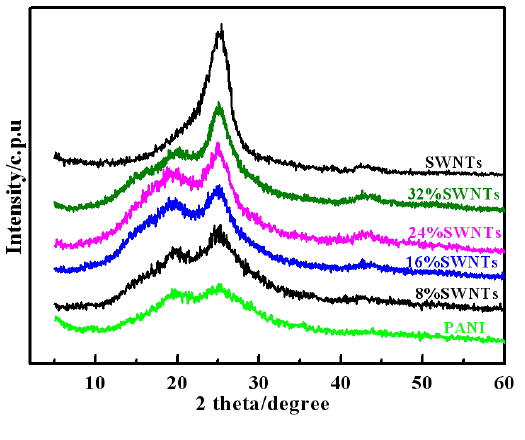
Figure 3. X-ray diffraction (XRD) patterns of SWNTs, PANI and PANI/SWNTs composites with a content of SWNTs varying from 8 wt% to 32